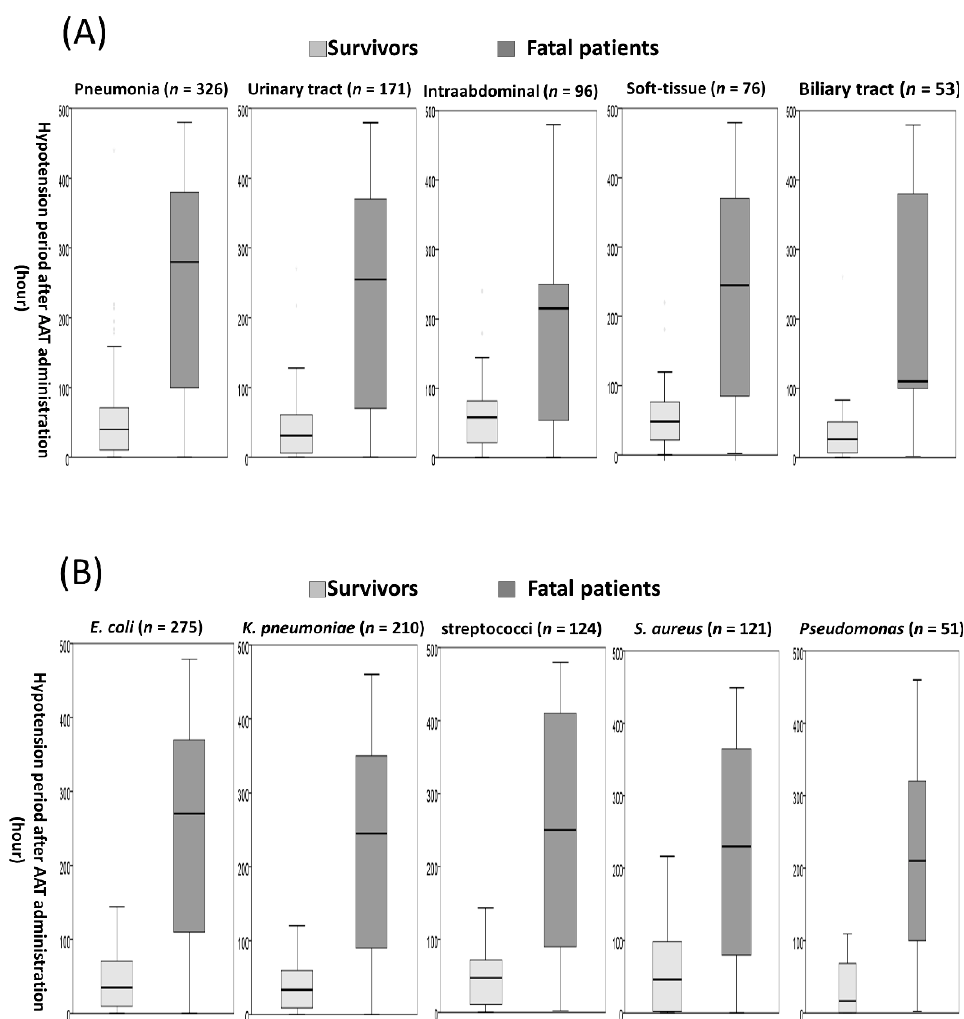
Figure 4. The boxplot of the hypotension period after AAT initiation between survivors and fatal patients within 30 days after bacteremia onset in leading bacteremia sources ( A ) and causative microorganisms ( B ). AAT = appropriate antimicrobial therapy.